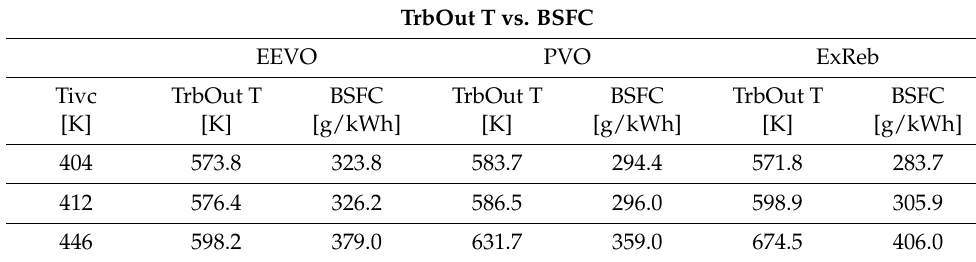
Figure A1. Comparison of total residual cylinder-to-cylinder variations among the exhaust rebreathe strategies at the total residual gas split 50:50. Table A1. Effects on temperature and BSFC for different valve actuation strategies at B10.